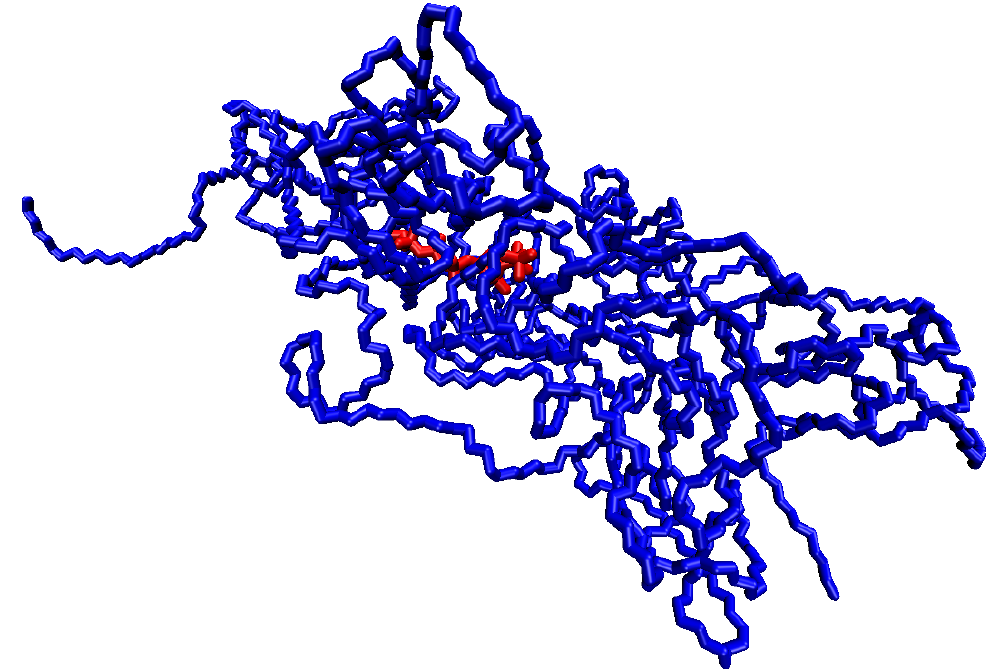
Figure 1. Snapshot of the molecular dynamics (MD) trajectory at the beginning of the last nanosecond. T = 313 K. Only carbon atoms are shown, with PVA and PMA in blue and red, respectively. Water molecules are omitted.